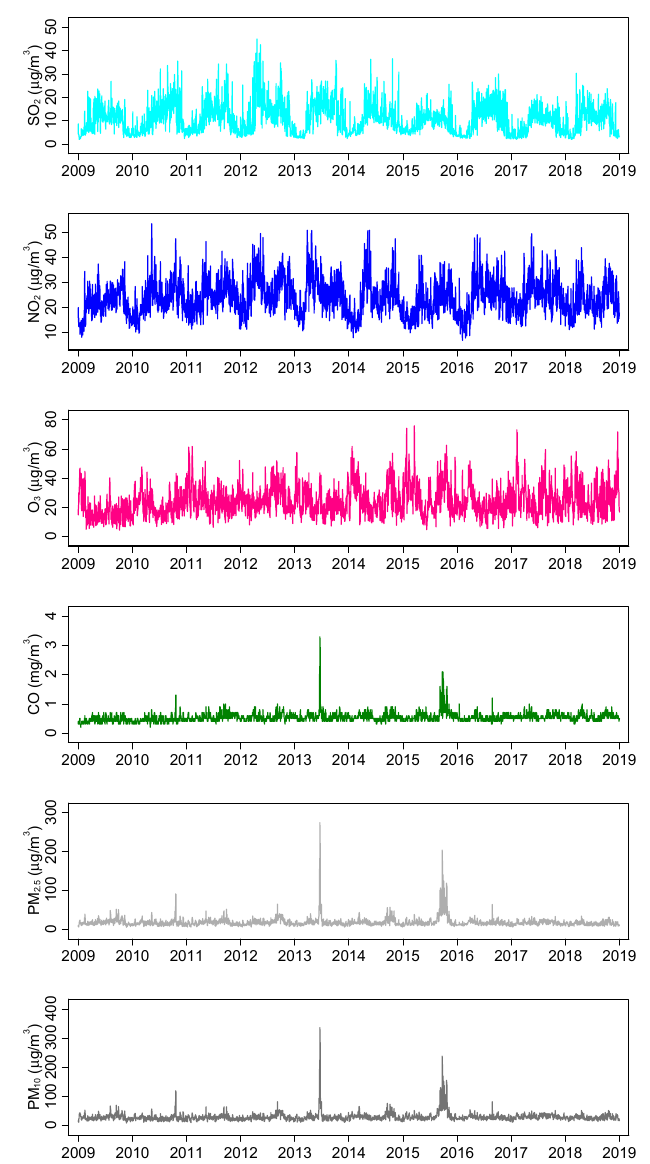
Figure 1. Trend of daily air pollutant concentrations in Singapore from 2009–2018.